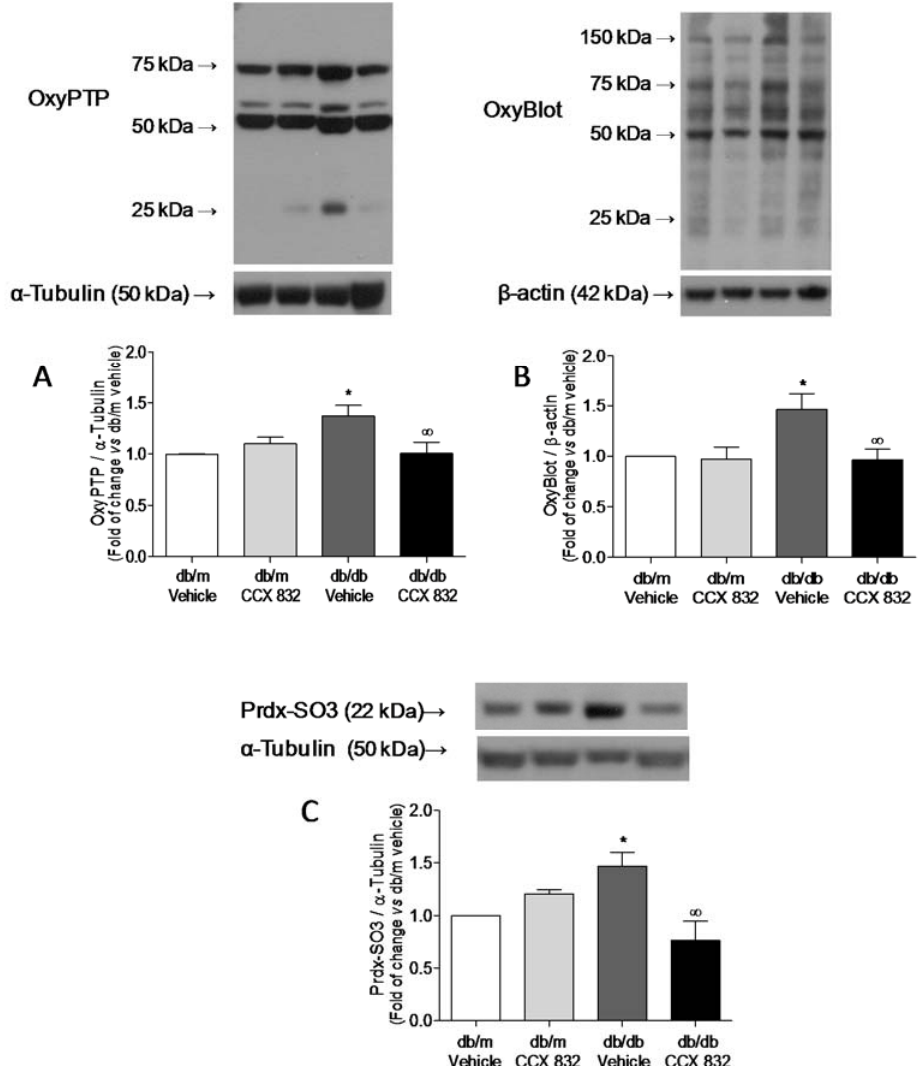
Figure 3. ChemR23 antagonism decreases renal carbonylation, protein-tyrosine phosphatases (PTPs) and Prdx oxidation in db/db mice. The experiments were performed in kidneys from vehicle or CCX832-treated db/m and db/db mice. ( A ) PTPs oxidation was assessed by western blot. ( B ) Protein carbonylation was assessed by OxyBlot. ( C ) Prdx-SO 3 oxidation was assessed by western blot. The values were normalized by α -tubulin or β -actin expression. Bars represent the mean ± SEM of 5 to 8 experiments. * p < 0.05 vs. db/m, ∞ p < 0.05 vs. db/db vehicle .